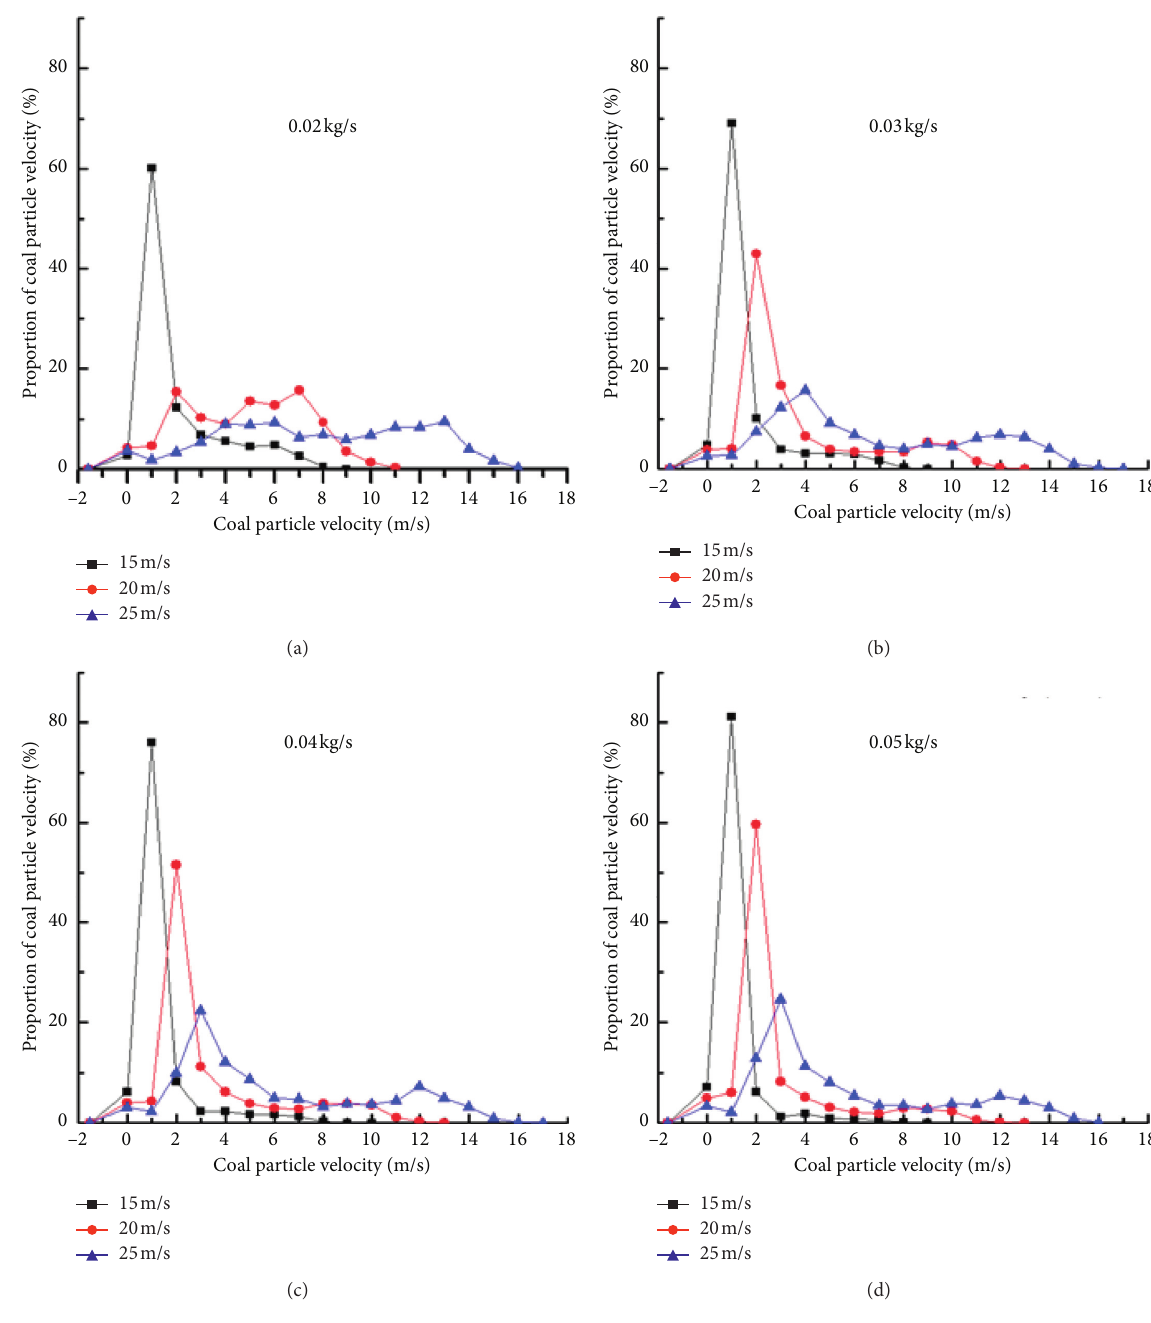
Figure 16: Percentage of different particle